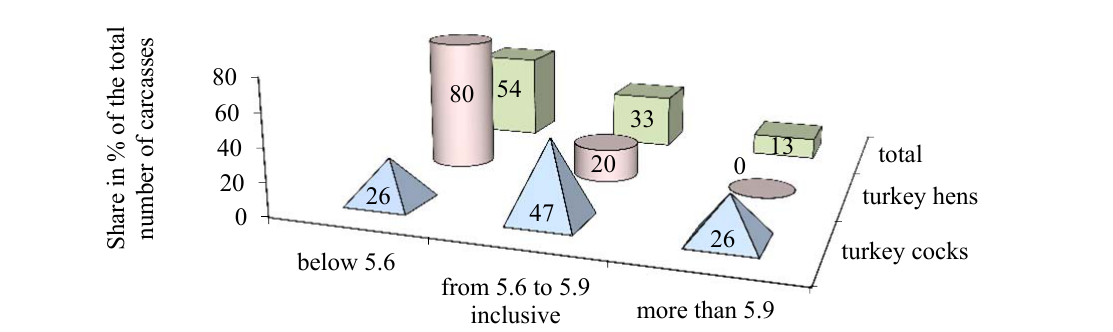
Fig. 1. Division of turkey meat into quality groups based on pH